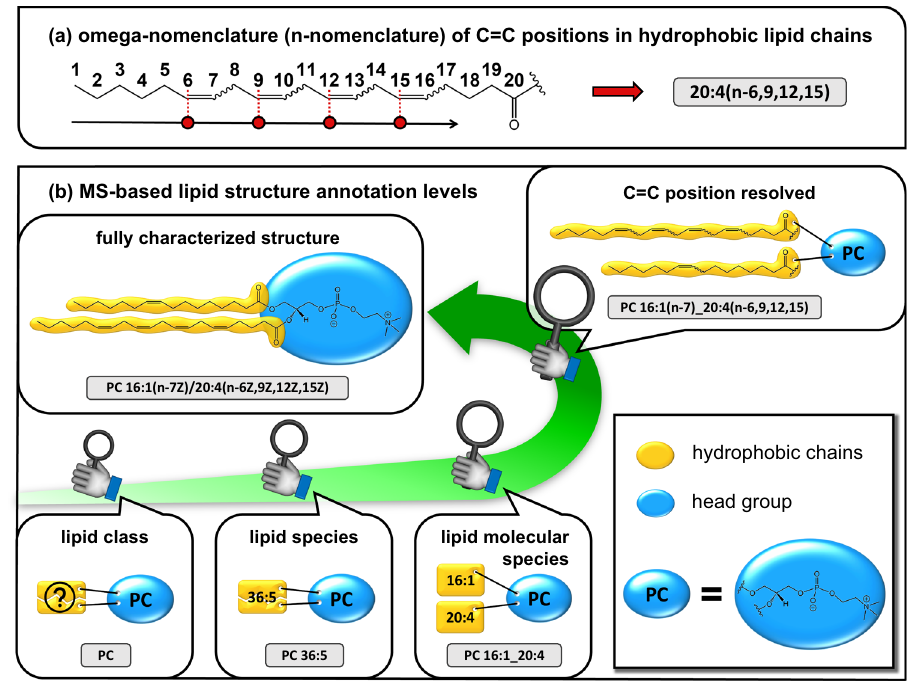
Fig. 1 Lipid structure annotation levels including an illustration of the omega description. a omega-nomenclature illustrated by the example of arachidonic acid. According to the prevalent mass spectrometry (MS) shorthand nomenclature by Liebisch et al. 13 , arachidonic acid is referred to as 20:4 because it consists of 20 carbon atoms and four double bonds (C = C). Inthis notation, the n-nomenclature isindicatedby brackets whose content starts with ‘ n- ‘ followed by the corresponding C = C positions. The numbering of the carbons starts at the methyl group. b MS-based structural annotation levels. Hydrophobic chains are indicated in gold, and blue ovals represent phosphocholine including the glycerol backbone. The lowest structurally resolved lipid identi fi cation is the lipid class level, which provides an aggregate measure for all species pertaining to a particular lipid class, e.g., in this case, phosphatidylcholine (PC). At this level, no information on the attached hydrophobic chains is available. The lipid species level resolves the constituent species of a class by their respective molecular mass. As for the structure, only the sum of the number of carbon atoms and the sum of C = C contained in the chains can be resolved. Structural elucidation at the lipid molecular species level involves knowledge of the chain length and number of C = C in each of the constituent hydrophobic lipid chains. The C = C position level resolves C = C locations. This information can be provided by the n-nomenclature or the delta-nomenclature (numbering starts at the terminal carbon atom, which is involved in the heteroatomic bond with the rest of the lipid molecule). Ultimately, complete structural characterization is achieved when positions on the glycerol backbone ( sn -positions) and cis – trans isomerism are